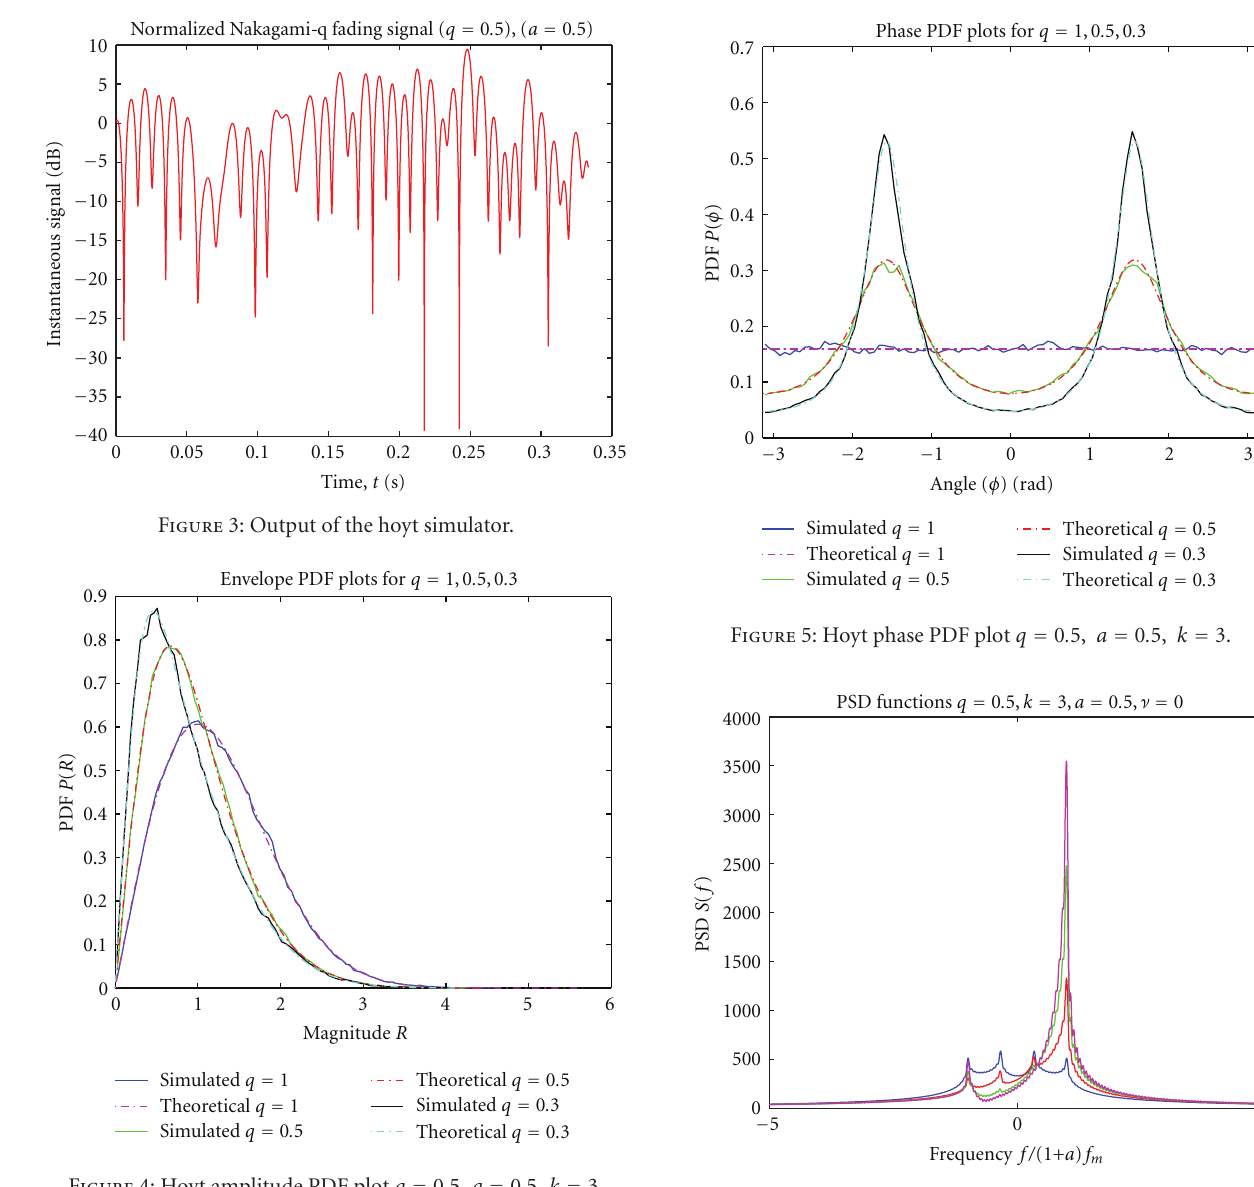
Figure 4: Hoyt amplitude PDF plot q = 0 . 5, a = 0 . 5, k = 3.